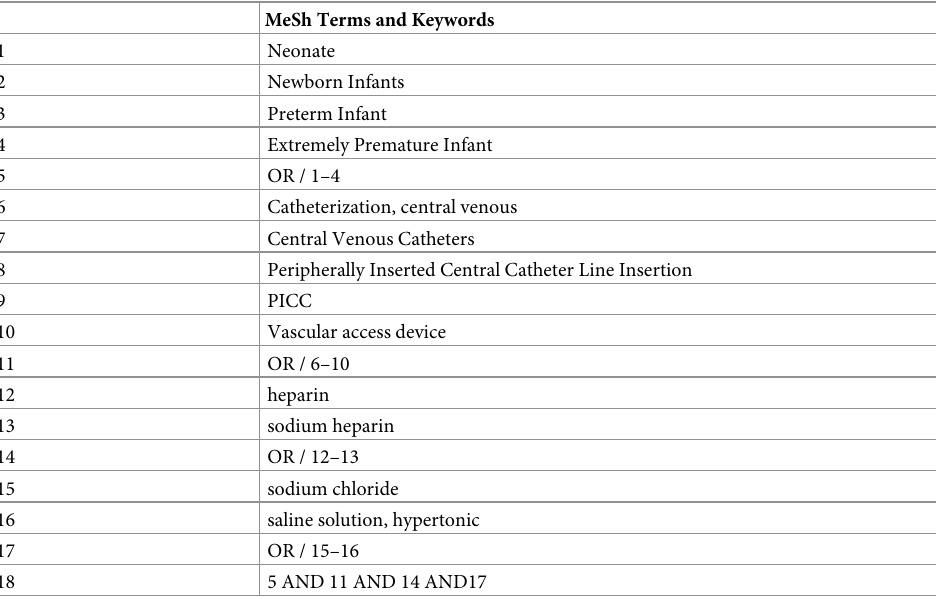
Table 1. Search strategy for PubMed. MeSh Terms and